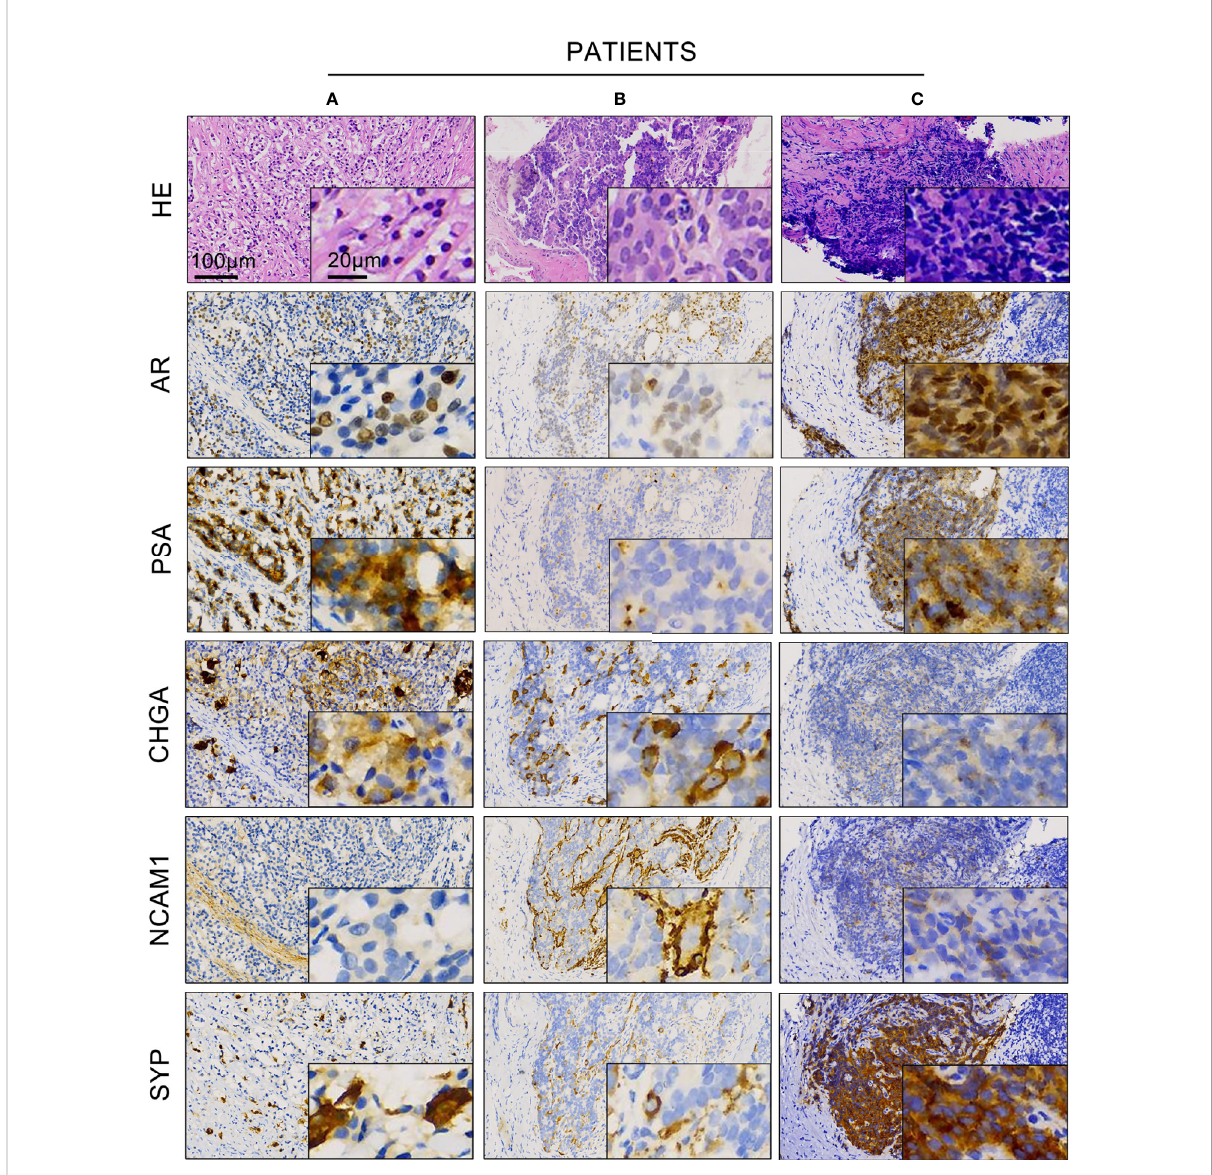
FIGURE 2 Expression of androgen receptor (AR), prostate-speci fi c antigen (PSA), and different neuroendocrine markers in prostate cancer with neuroendocrine differentiation. Representative hematoxylin and eosin and immunohistochemistry staining showed the expression of AR, PSA, CHGA, NCAM1, and SYP in prostate cancer patient samples (A – C) of the AR+